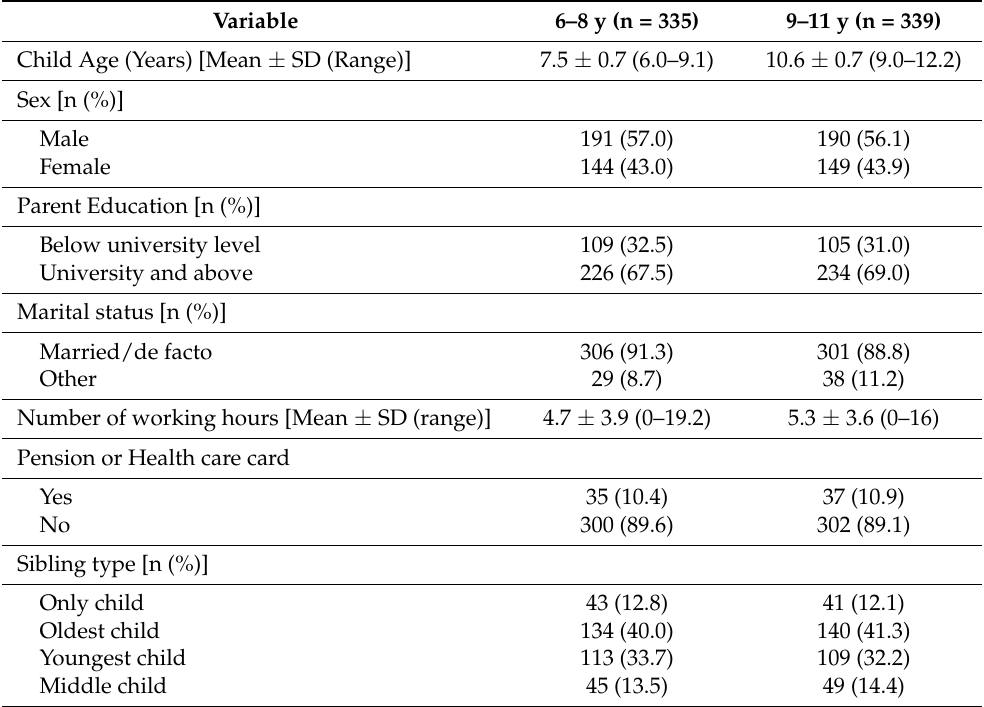
Table 1. Characteristics of the cohort at 6–8 y and 9–11